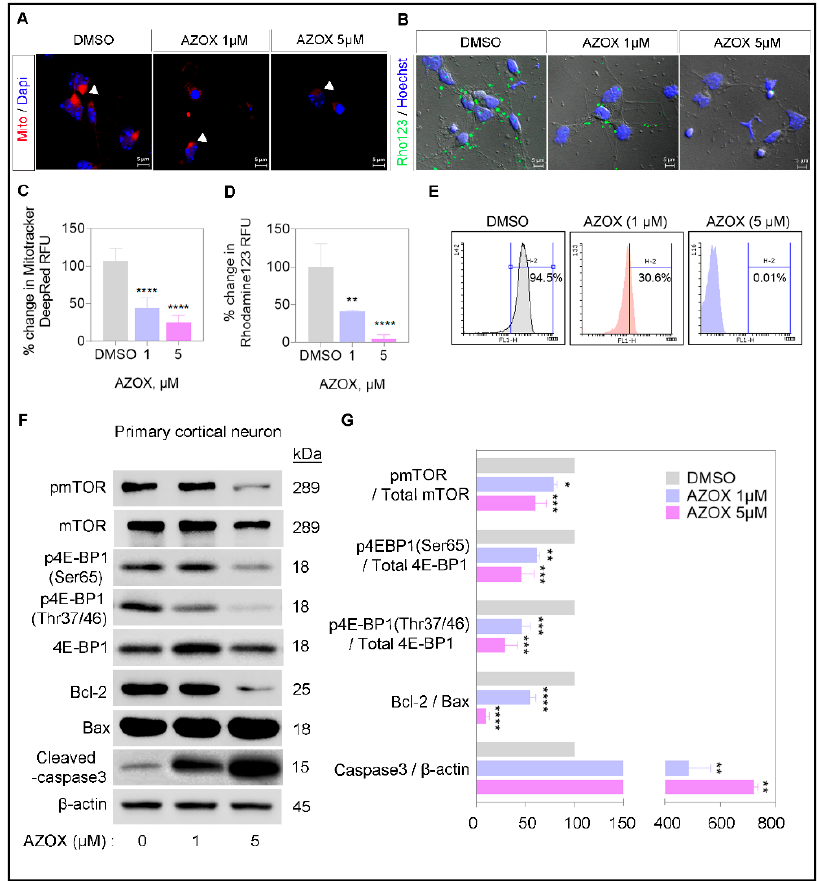
Figure 2. AZOX depolarizes the mitochondria membrane. ( A – D ) Mitochondria accumulation and MMP were examined by MitoTracker Deep Red and Rho123 staining in primary neurons, respectively. Fluorescence intensity was quantified using ImageJ software and plotted as a histogram. Scale bar corresponds to 5 µ m, data are presented as mean ± SEM; t -test: * p < 0.05, ** p < 0.01, *** p < 0.001, **** p < 0.0001. ( E ) Flow cytometry analysis of primary neurons stained with Rho123. ( F , G ) mTORC1 activity in the primary cortical neuron (DIV3) was quantified by Western blot, and the band densitometry was measured using ImageJ software. The histograms represent the band intensity, data are presented as mean ± SEM; t -test: * p < 0.05, ** p < 0.01, *** p < 0.001, **** p < 0.0001. β -actin was used as the loading